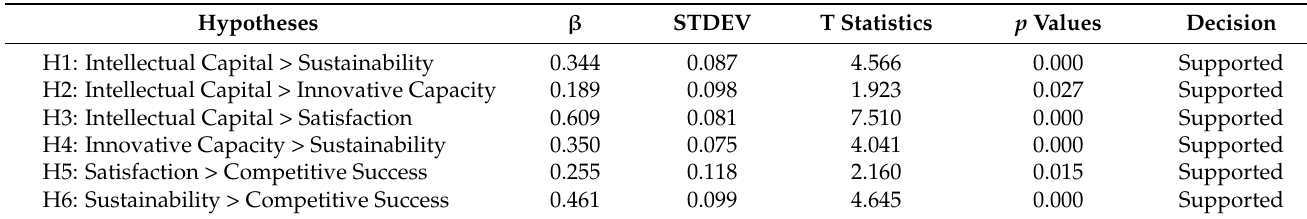
Table 6. Decision on the